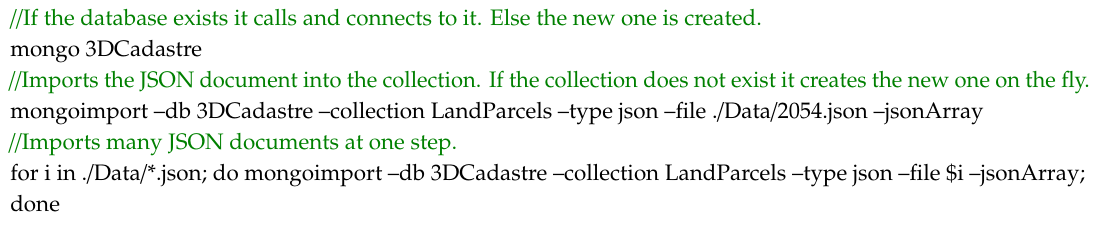
Algorithm 1: Code for creating a database, collection and importing a JSON document // If the database exists it calls and connects to it. Else the new one is created.